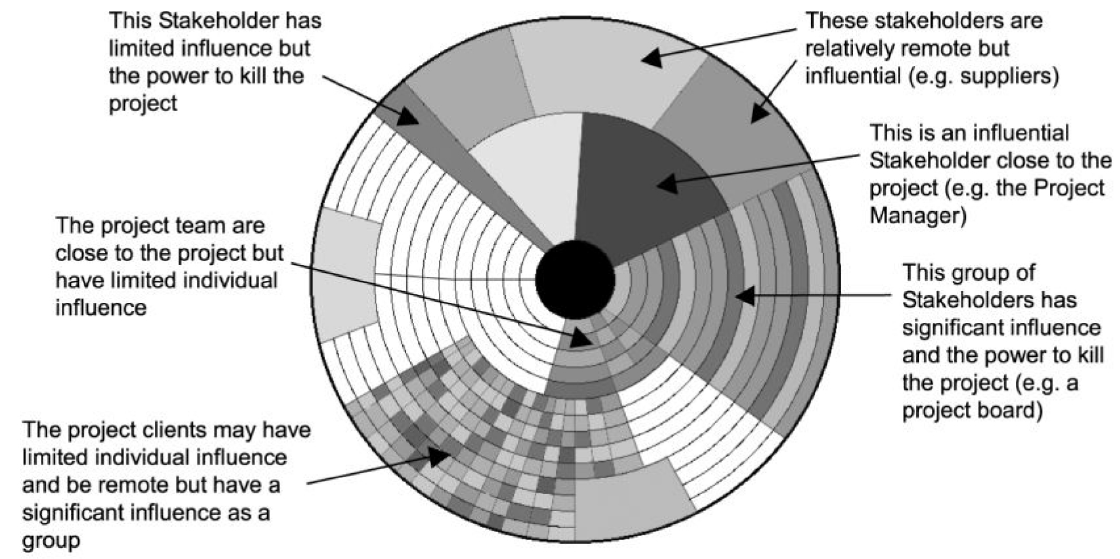
Figure 3. Stakeholder Circle (Bourne & Walker,